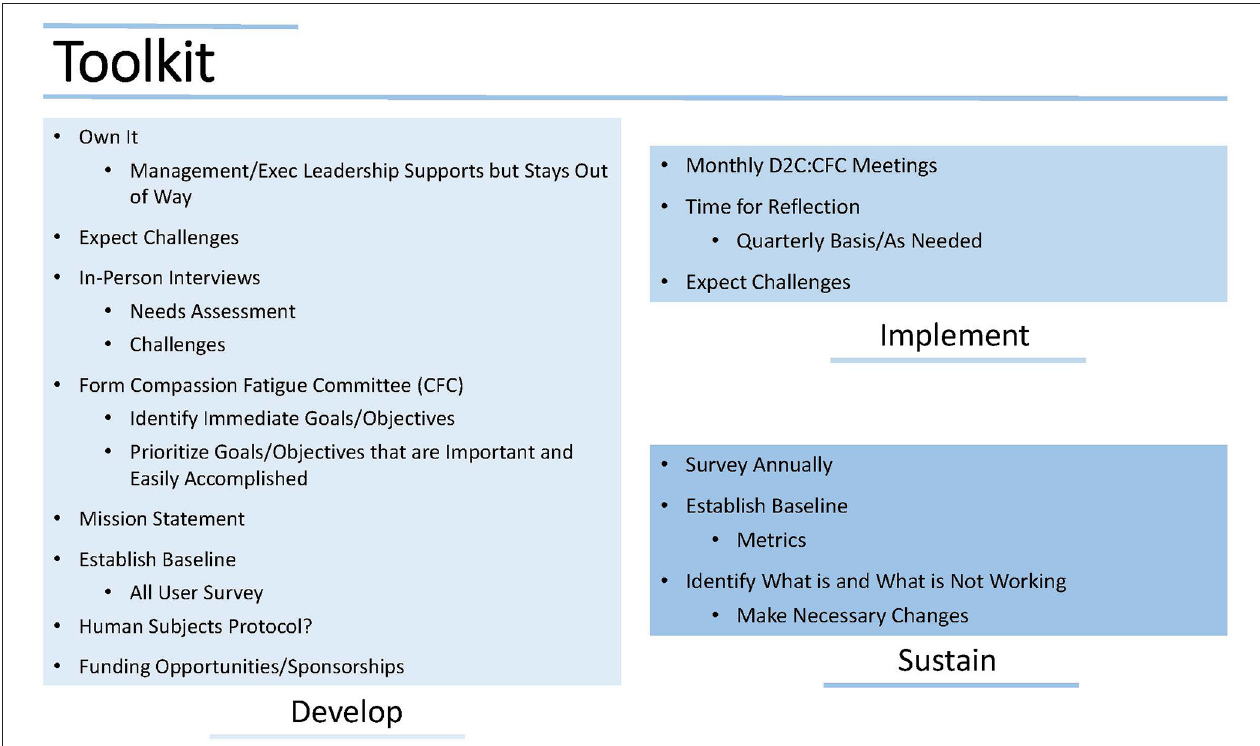
FIGURE 4 | D2C Toolkit provides the framework to develop, implement and sustain a compassion fatigue